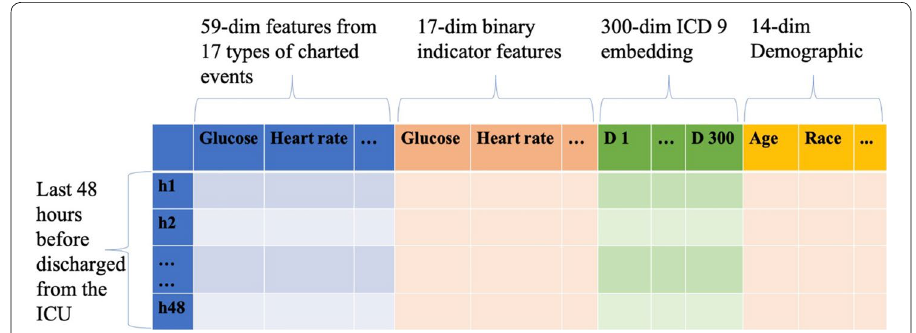
Fig. 4 Image copied from [51], structure of time series dataset shows mix of quantitative and qualitative data, including embedding of ICD-9